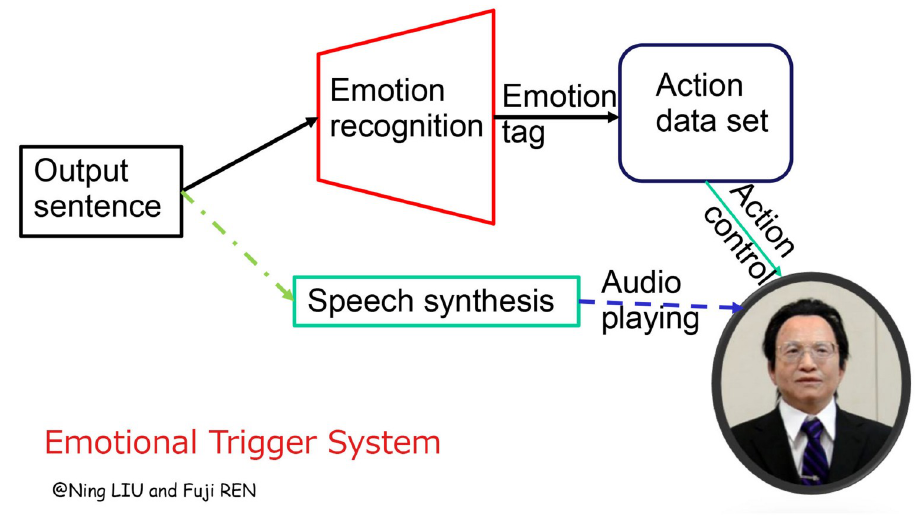
Fig 4. Flowchart of the Emotional Trigger